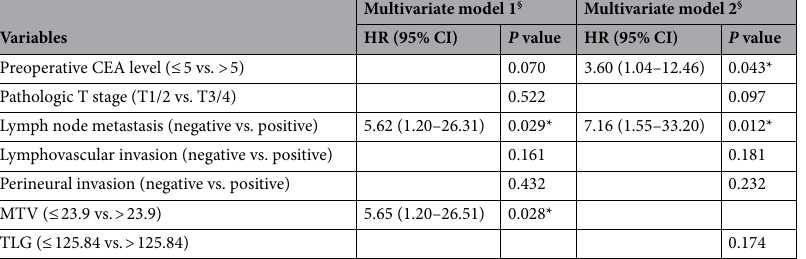
Table 4. Multivariate analysis of prognostic factors for overall survival. CEA carcinoembryonic antigen, CI confidence, HR hazard ratio, interval, MTV metabolic tumour volume, TLG total lesion glycolysis. § MTV (model 1) and TLG (model 2) were separately assessed in a stepwise multivariate Cox proportional hazards model. *Statistically significant.